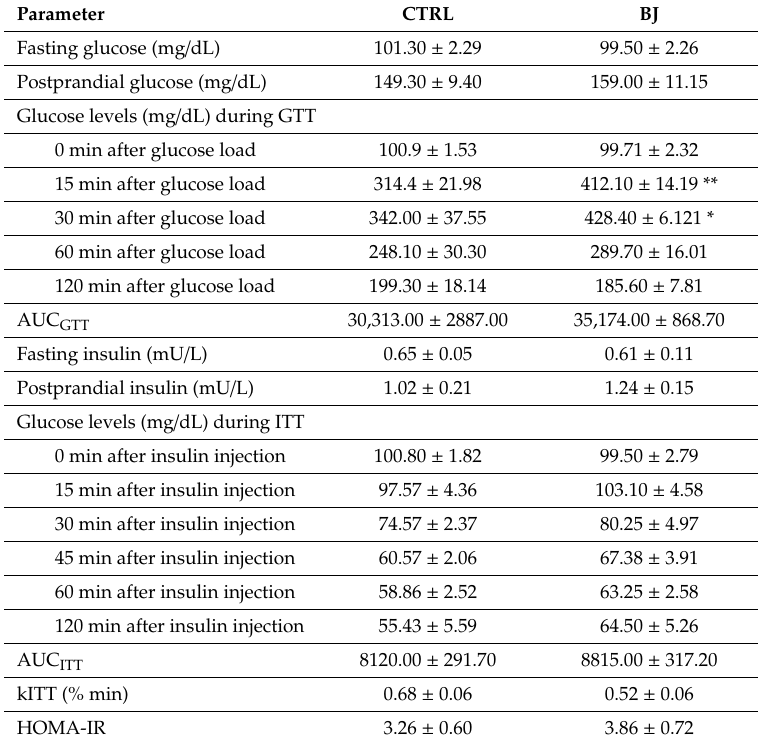
Table 3. Glycemic and insulinemic